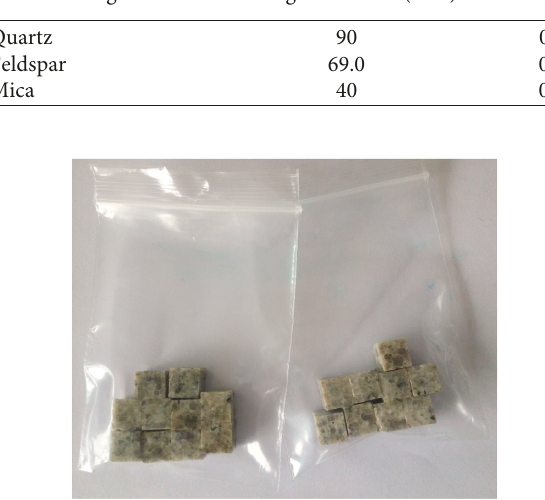
Table 2: The mechanical parameters of major rock-forming mineral [22, 23]. Rock-forming minerals